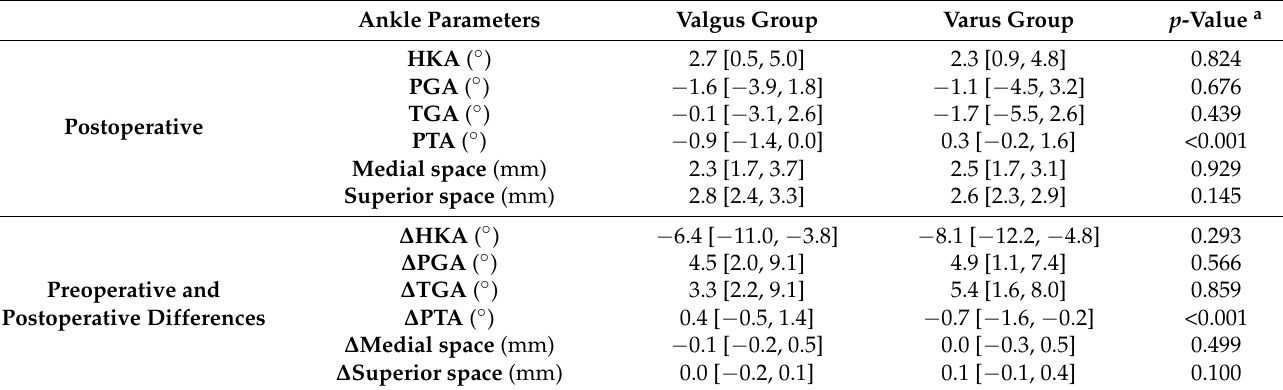
Table 4. Between-group comparison of radiographic